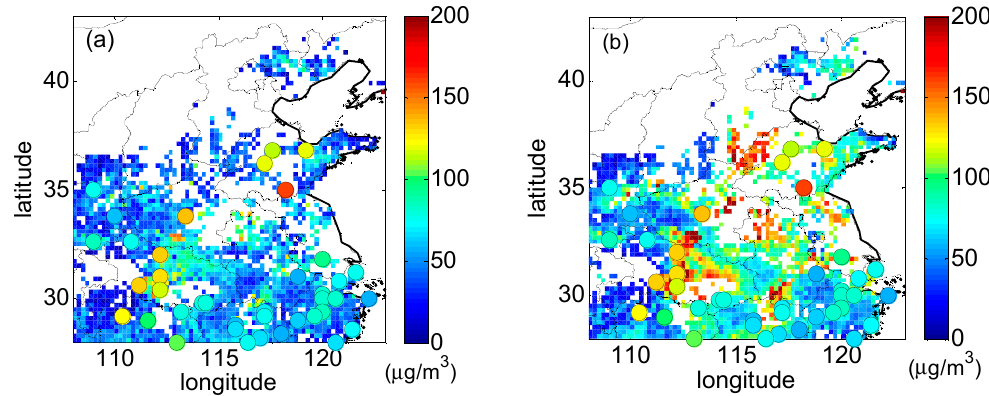
Figure 6. ( a ) PM 2.5 (atmospheric particulate matter with a mass median diameter less than 2.5 μ m) mass concentration near the ground estimated from FMF observations; and ( b ) FMF fusion results based on UK method for a time period from 9 February to 15 February 2015. The colored solid circles in the figures are PM 2.5 measurements from the Ministry of Environmental Protection (MEP). The white gaps indicate no values.